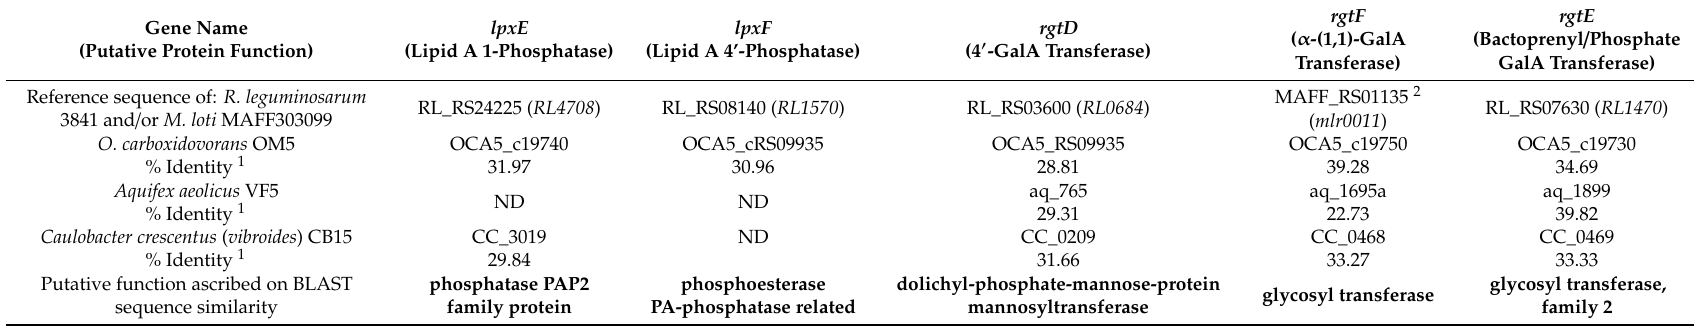
Table 4. Sequence similarity of putative proteins involved in lipid A modification in Oligotropha carboxidovorans OM5, Aquifex aeolicus and Caulobacter crescentus CB15 with enzymes of known functions from the reference strains: Rhizobium leguminosarum bv. Viciae 3841 and Mesorhizobium loti MAFF303099).